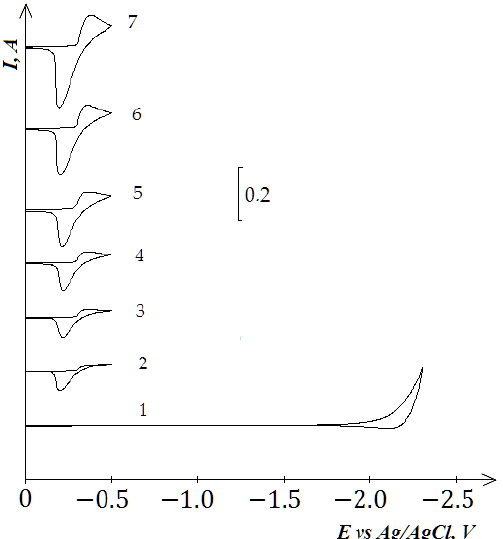
Figure 4. Cyclic voltammograms of the KCl-NaCl-CoCl 2 melt recorded on the tungsten electrode at 973 K and at different polarization rates: curve 1–0.2 V/s, curve 2–0.02, curve 3–0.05 V/s, curve 4–0.1 V/s, curve 5–0.2 V/s, curve 6–0.5 V/s, curve 7–1.0 V/s. Curve (1) denotes the background KCl-NaCl (1:1) electrolyte; a square of the cathode is 0.64 cm 2 .